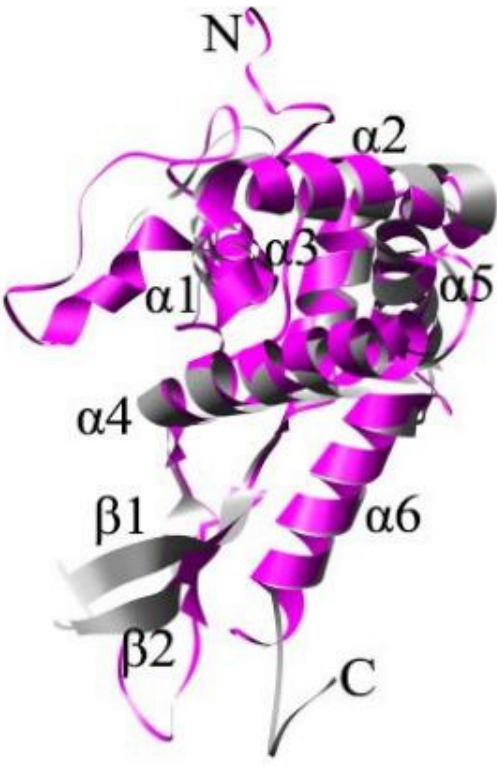
Figure 1. Three-dimensional structure of RPS5 has a common backbone comprising six α -helices, two β -strands, and seven loops.